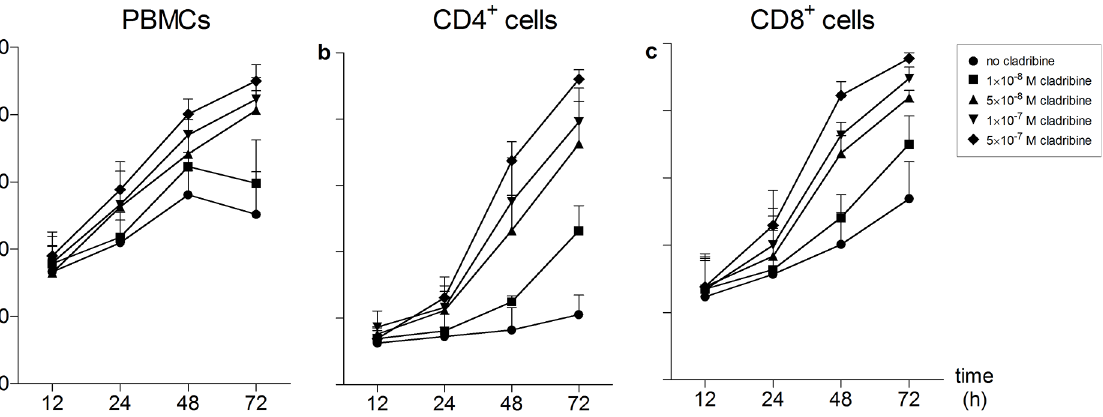
Fig 2. Apoptosis of stimulated PBMCs, CD4 + cells and CD8 + cells caused by cladribine in vitro PBMCs (a, n = 3), CD4 + cells (b, n = 3) and CD8 + cells (c, n = 3) were stimulated with anti-CD3/anti-CD28 antibodies and were incubated in the absence or presence of cladribine (1×10 − 8 M to 5×10 − 7 M) for 12, 24, 48 and 72 h. Apoptotic cells were defined as Annexin V positive cells. Data are depicted as mean + standard deviation (SD).